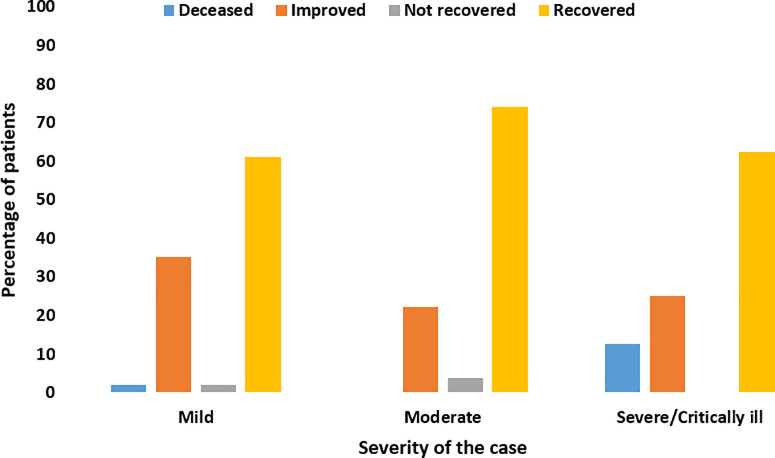
Clinical severity stratified by gender.